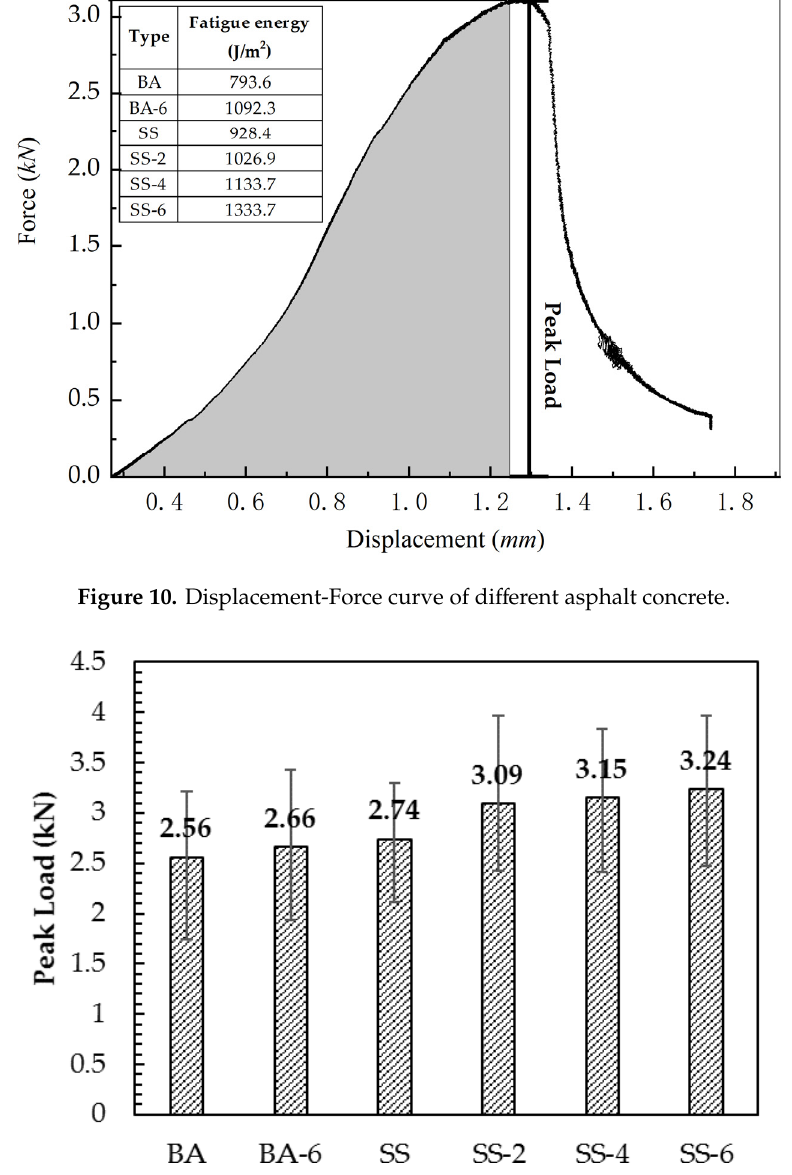
Figure 11 Peak load of different asphalt concretes.